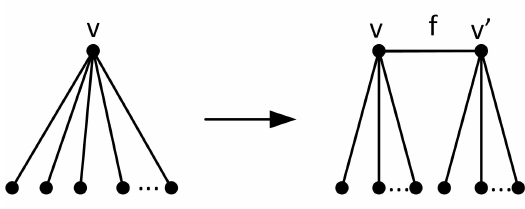
Figure 2. Tutte’s vertex split operation.